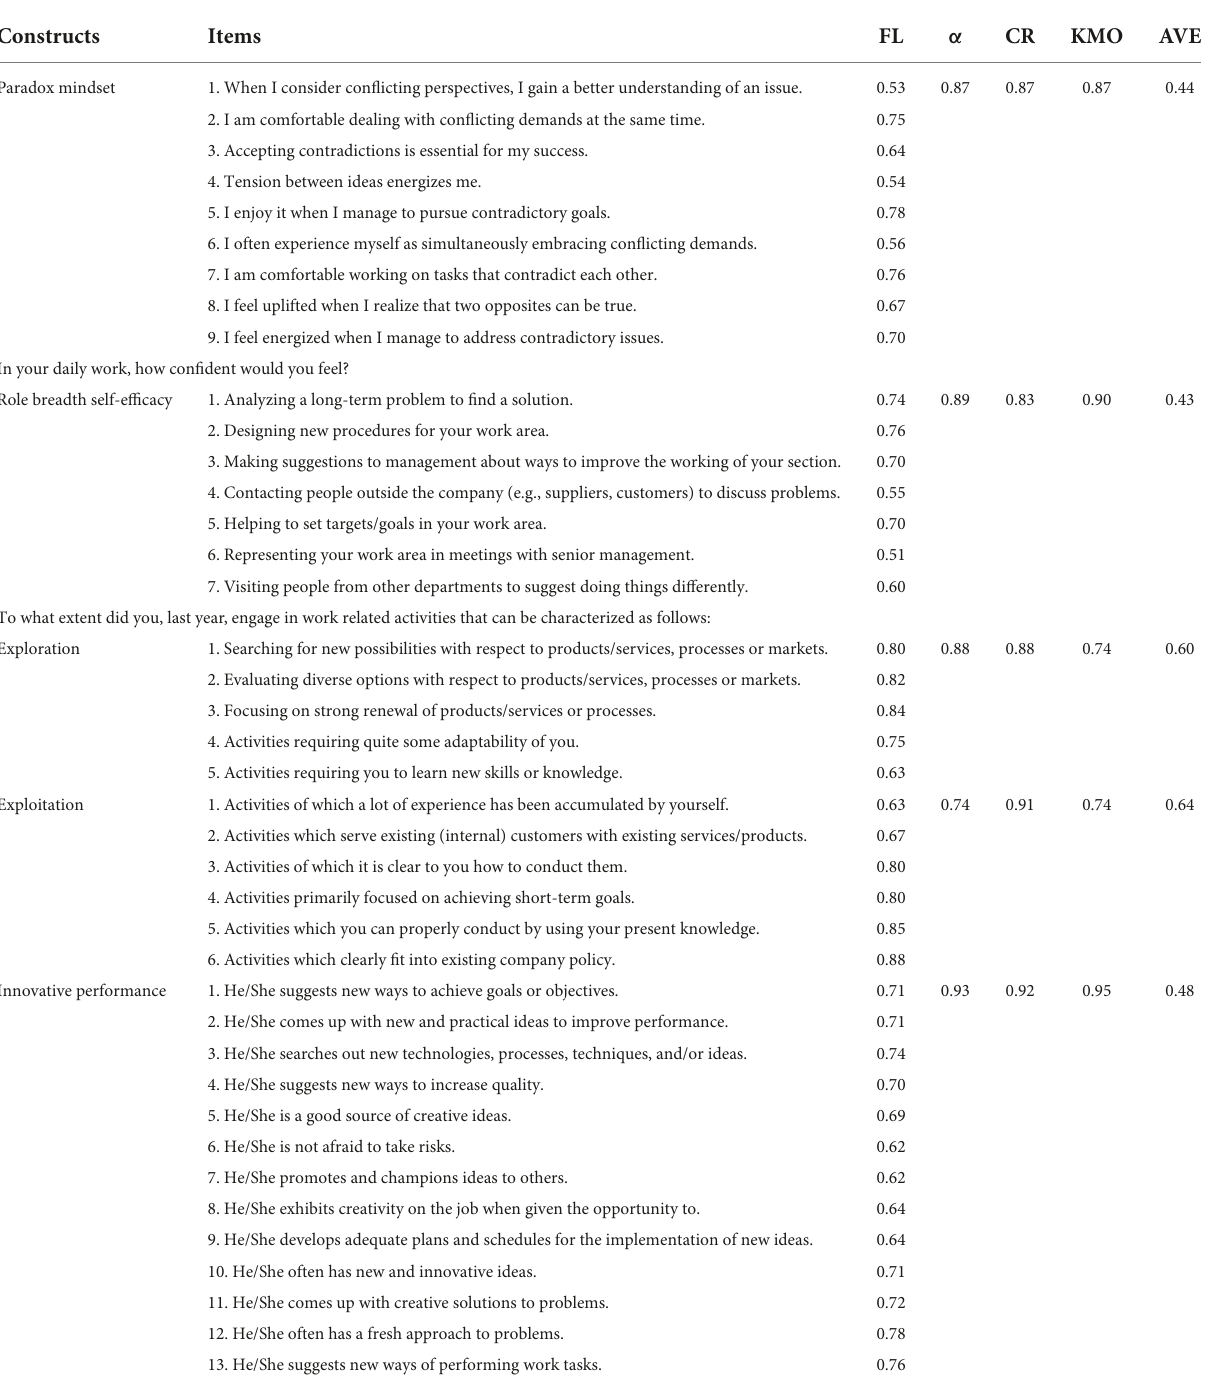
TABLE 1 Measurement items, reliability, and validity tests. Items